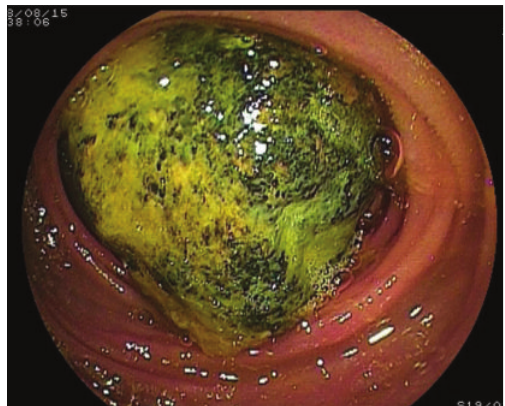
Figure 3: DBE shows yellow, hard bezoars blocking the distal ileum.